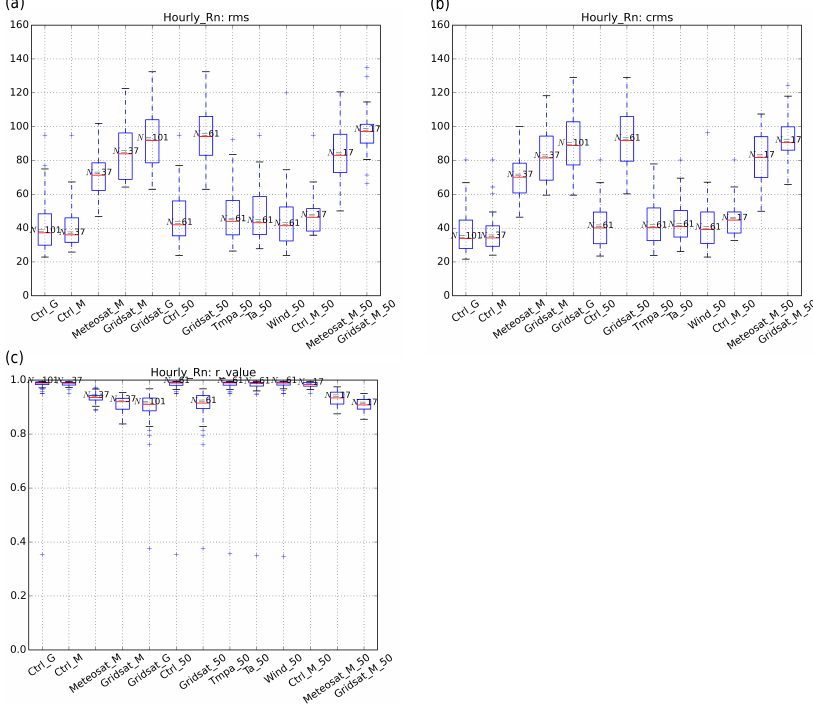
Figure 5. Box plots of validation statistics that are calculated at each station for surface net radiation ( R N ) for hourly data and all experiments investigated: (a) RMSD, (b) cRMSD, (c) correlation coefficient. The box corresponds to the inner-quartile range of the data and the red line indicates the median value. Numbers indicate number of model years for each